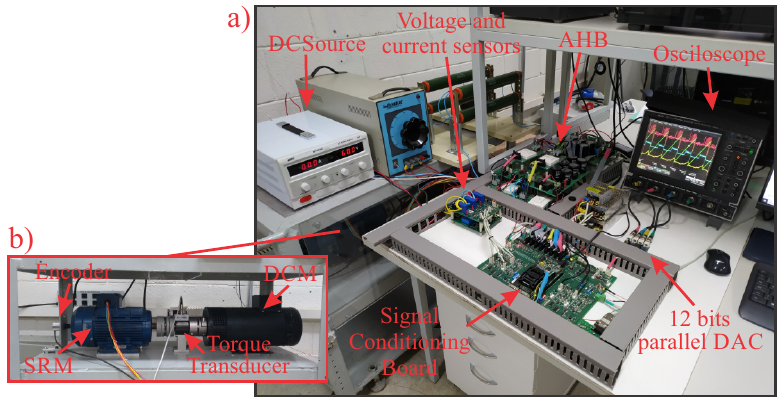
Figure 10. Experimental setup. DAC: digital-to-analog converter; DCM: DC machine.